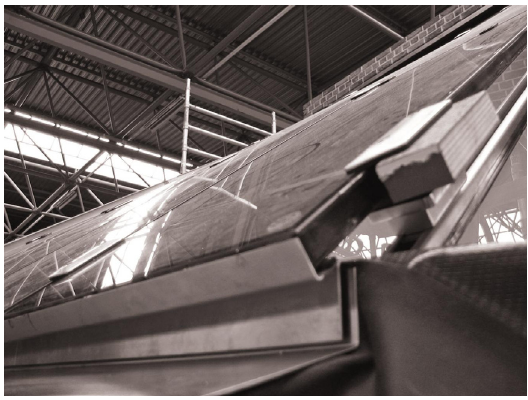
Figure 12: Hypar surface of